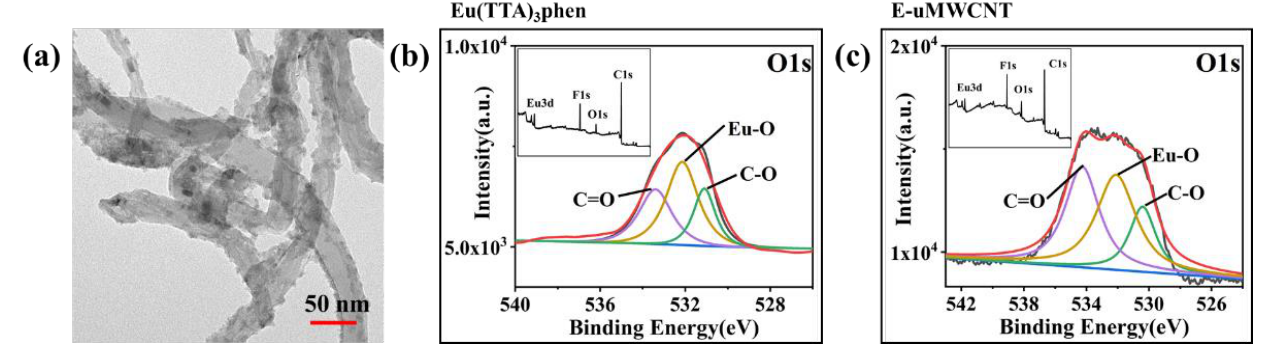
Figure 4. ( a ) TEM image of E-uMWCNTs; ( b ) XPS spectra of Eu(TTA) 3 phen; ( c ) XPS spectra of E-uMWCNTs.